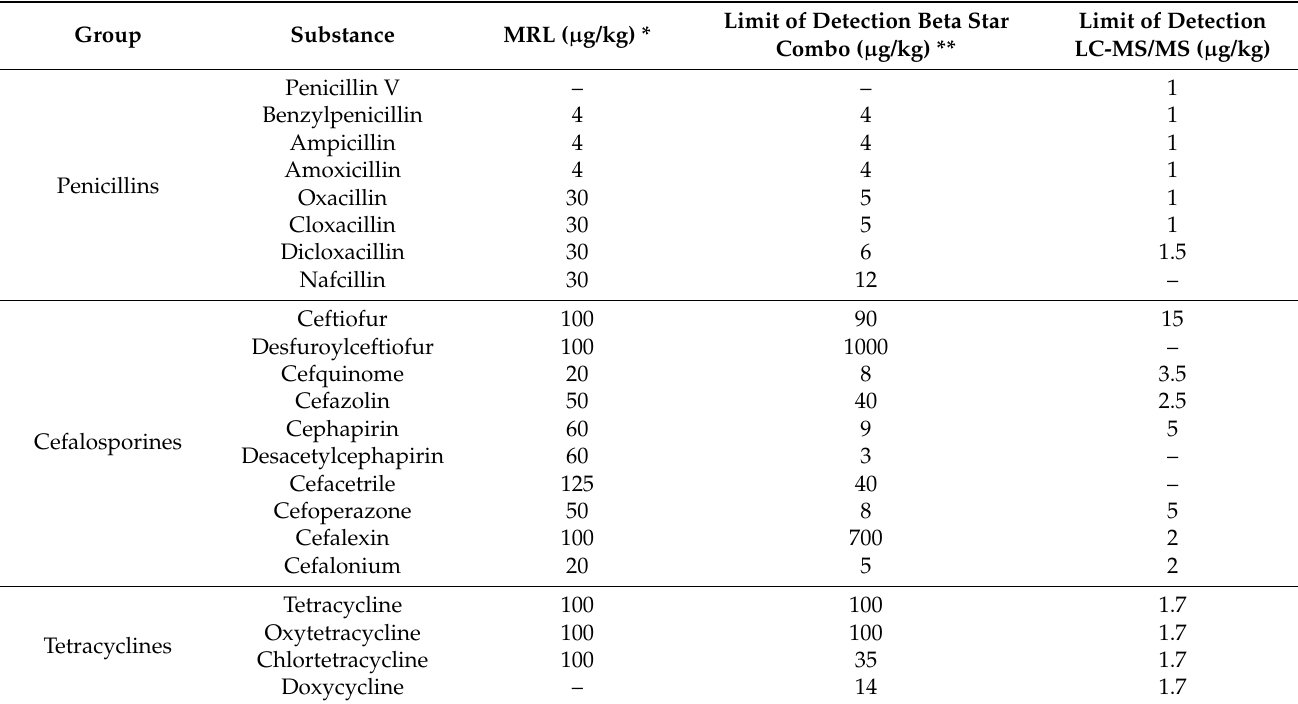
Table 1. Limits of detection for antimicrobial drugs by BetaStar ® Combo and